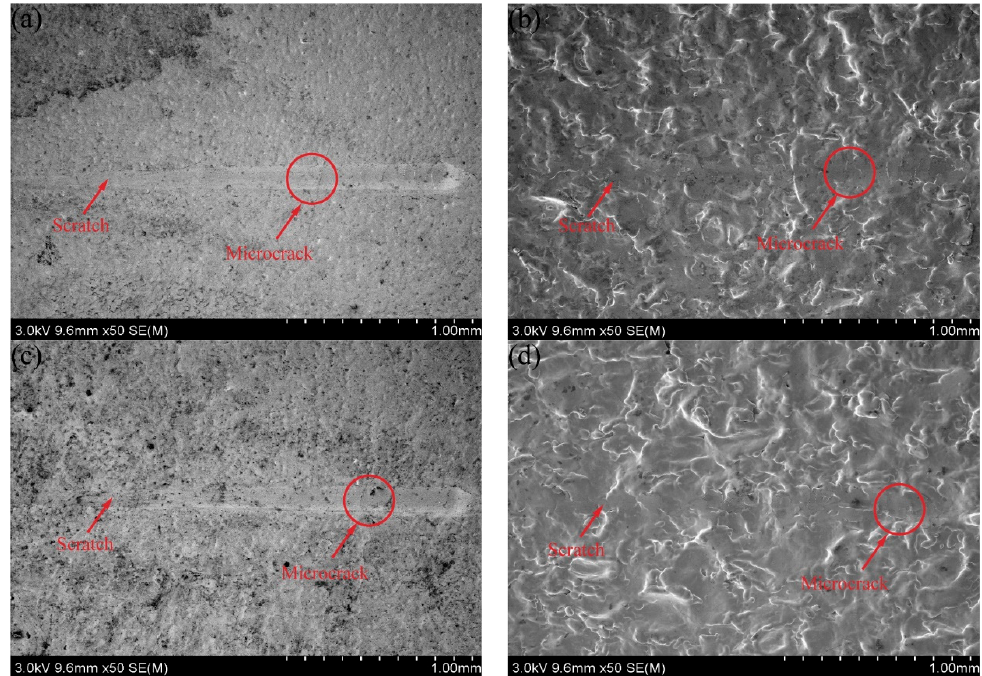
Figure 8. Scratch morphologies of coatings prepared by scanning electrodeposition on 45 steel